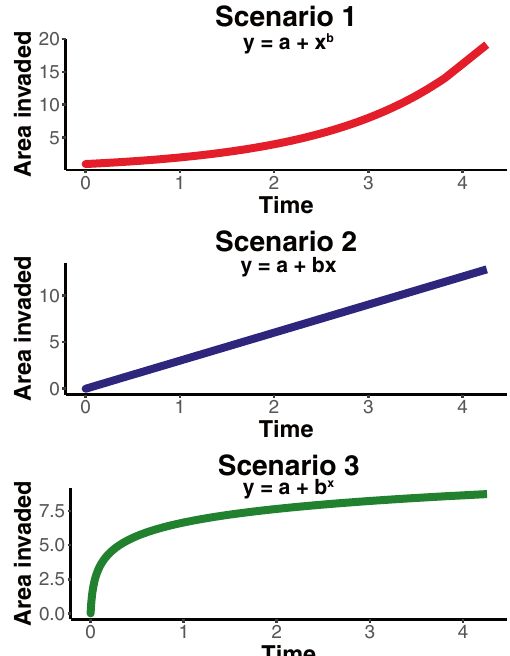
Figure 1. Theoretical scenarios of invasive species spread, based on exponential, linear, and power generic